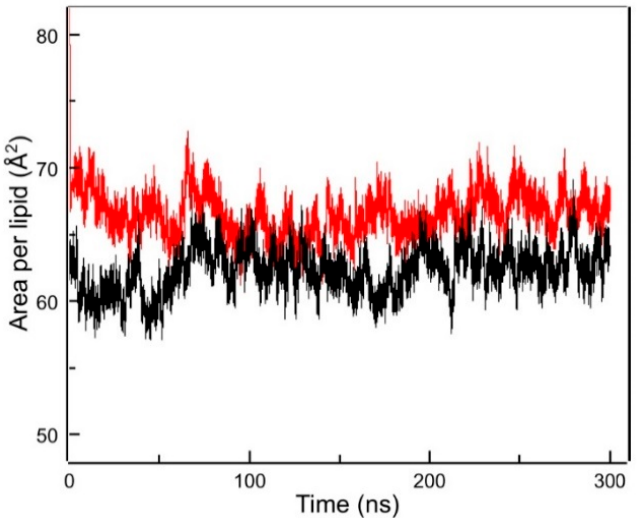
Figure 7. Area per lipid vs. simulated time for pure DMPG (black line) and DMPG containing TMBC (red line). Last 60 ns were used for all MD analysis.